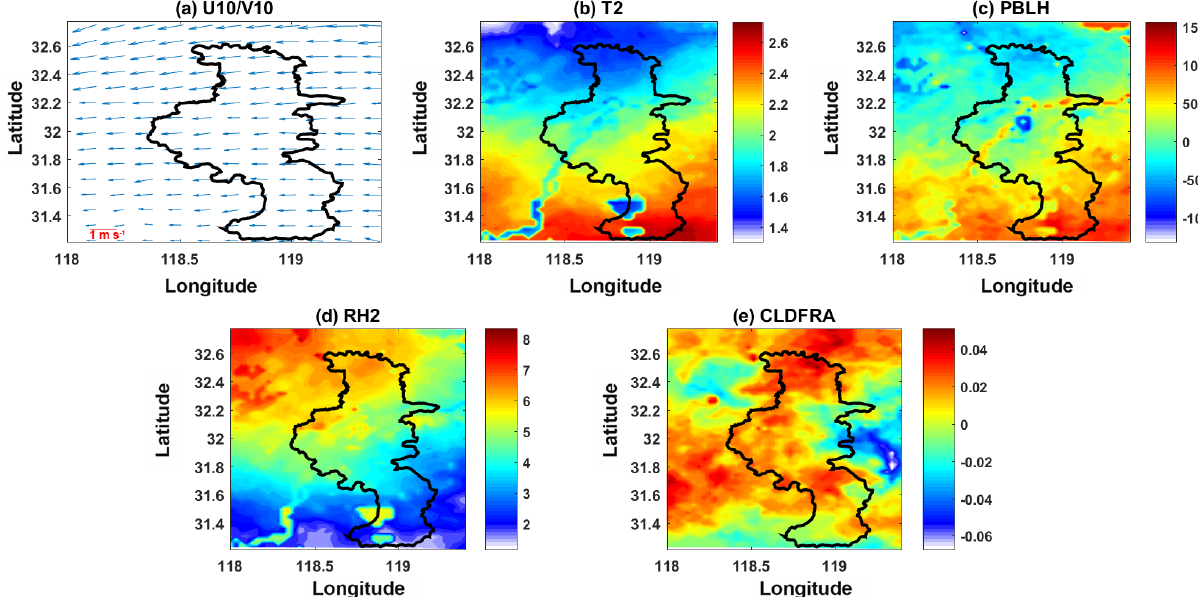
Figure 9. Bias of simulated hourly mean meteorological conditions during the YOG. Bias is meteorological factors on 16–28 August 2013 − meteorological factors on 16–28 August 2014. (a) Bias of wind at 10m during 16–28 August (ms − 1 ), (b) bias of temperature at 2m during 16–28 August (K), (c) bias of planetary boundary layer height during 16–28 August (m), (d) bias of relative humidity at 2m during 16–28 August (%), (e) bias of cloud fraction during 16–28 August.